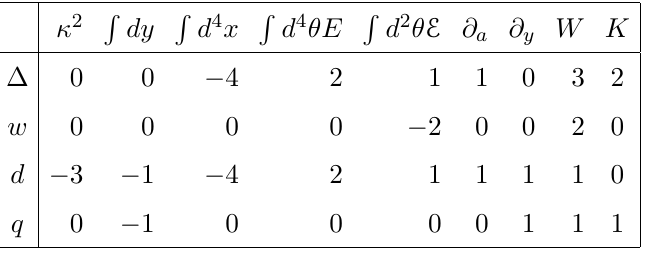
Table 2 . Weyl ((cid:1)) and U(1) R ( w ) weights of various measures and actions. W and K stand for the integrands of F- and D-term superspace